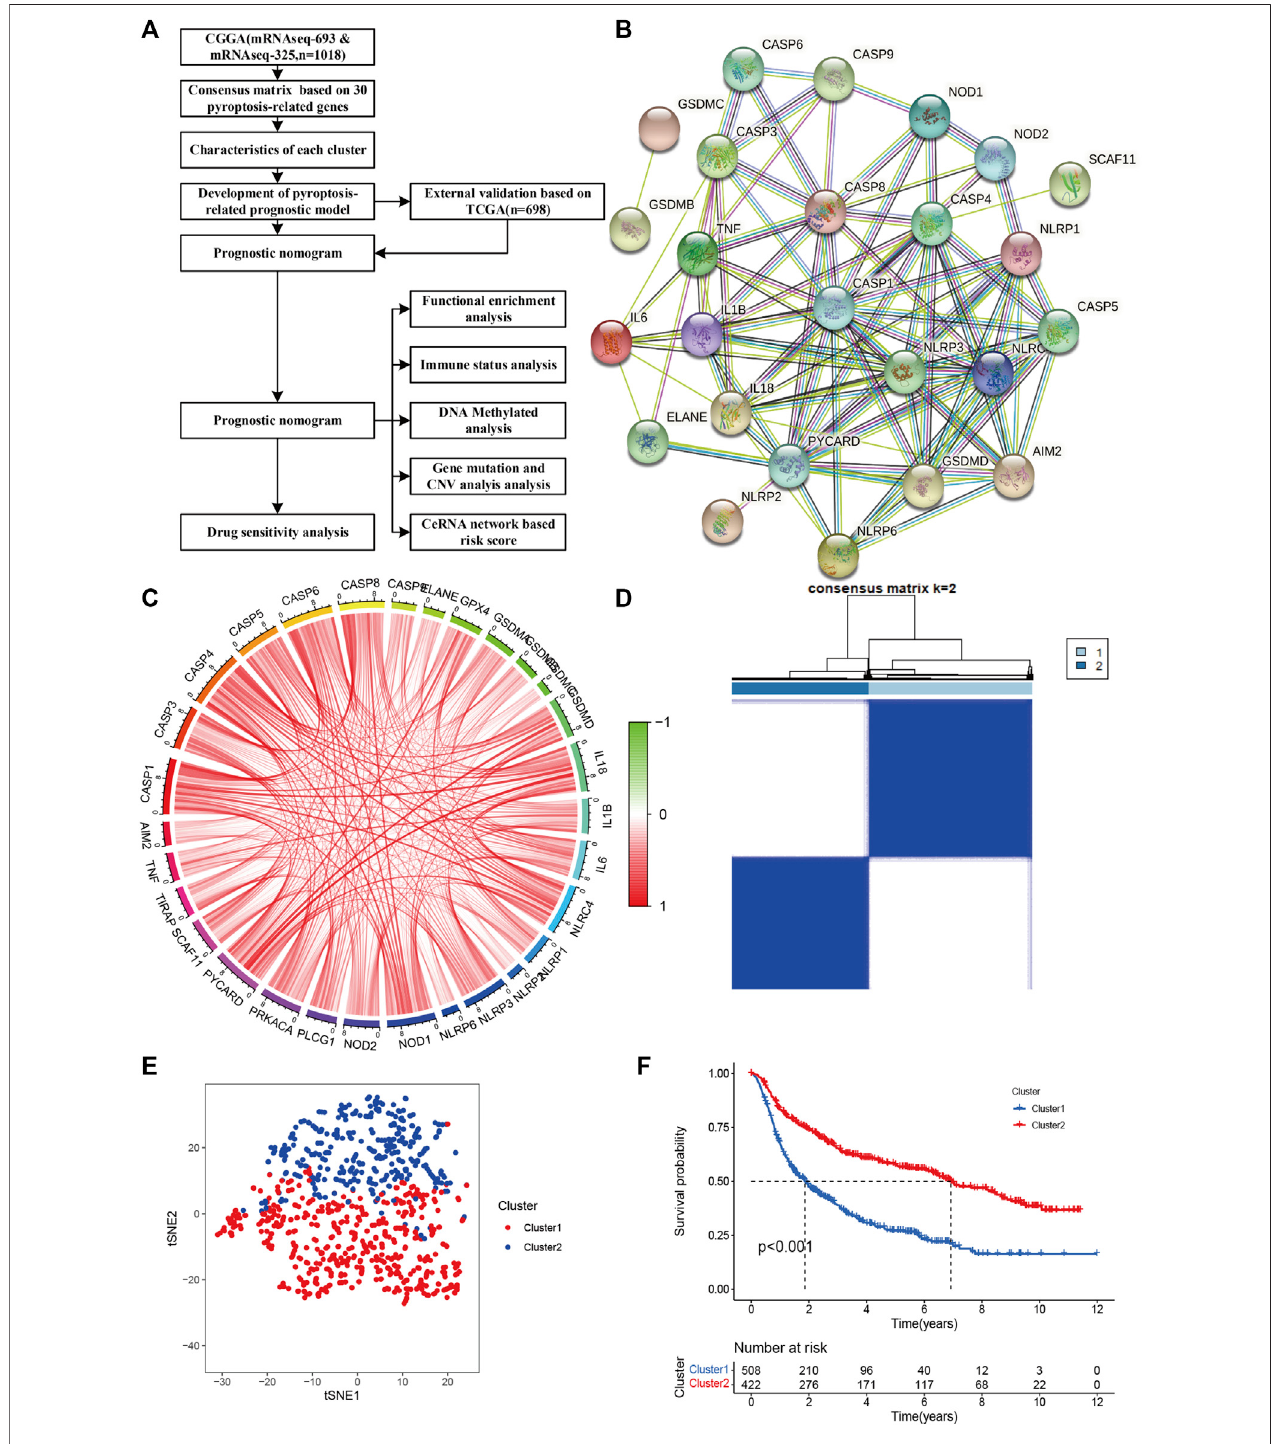
FIGURE1| Identi fi cationofgliomasubclassesusingconsensusclusteringmethodintheCGGAdataset. (A) Flowchartofthestudy. (B) PPInetworkindicatingthe interactions among pyroptosis-related genes (interaction score (cid:1) 0.7). (C) The circle plot ofcorrelation among pyroptosis-related genes (green line: negativecorrelation, red line: positive correlation). (D) Consensus matrix method clustering using 30 pyroptosis-related genes. (E) PCA analysis showed the distribution of two glioma subclasses in the CGGA dataset. (F) Overall survival curve of two clusters in the cohort.